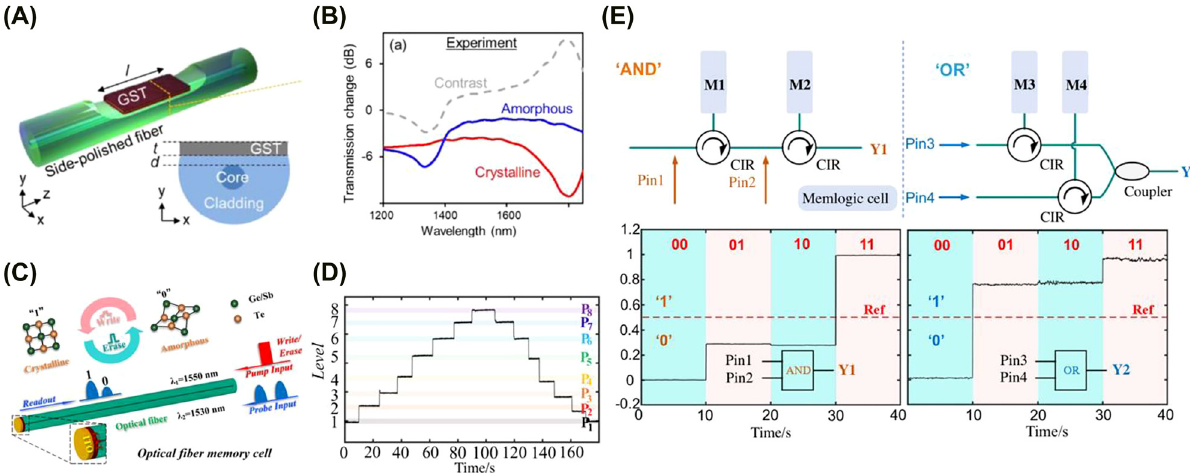
Figure 3: (A) and (B) PCM integration in side-polished optical fiber [49]. (A) Schematic of a PCM integrated optical fi ber device capable of recon fi gurabletransmissionattenuation.(B)Experimentallymeasuredspectraltransmissionchangeresultedfromamorphous(blueline)and crystalline (red) GST modulations. (C – E) PCM integration in end-polished optical fi ber [50]. (C) Operation principle of the PCM-based all- fi ber memory device. Amorphous GST, the low-re fl ectivity state, stores logic state 0 while crystalline GST, the high-re fl ectivity state, stores logic state1.(D)Experimentaldemonstrationofeightstoragelevelsreachedsequentially.(E)Experimentaldemonstrationoflogicoperations.Left: “ AND ” logicperformedis performedbyconnectingto cellsinseries.Right: “ OR ” logicis performedbyplacingtwocellsinparallelandthetwo outputs are combined with a